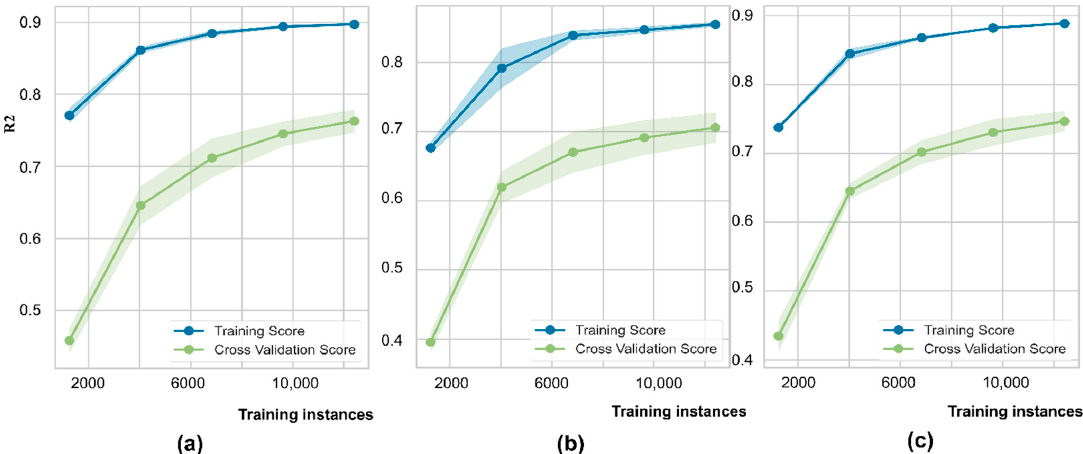
Figure 8. Learning curves of training versus 5-fold cross-validation: ( a ) As model; ( b ) Fe model; and ( c ) Mn model.